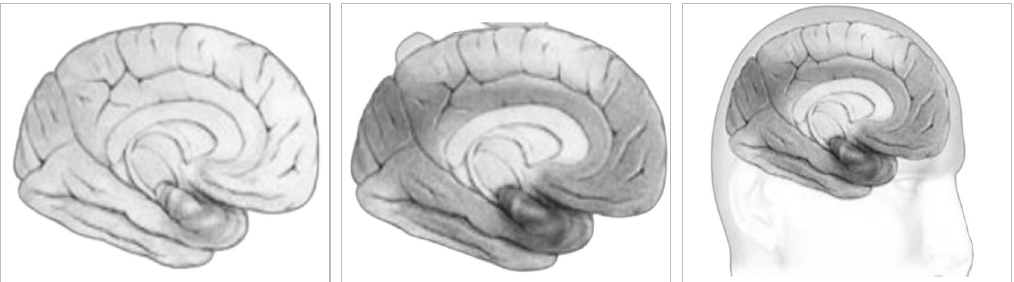
Figure 5: Senile plaques and neurofibrillary tangles in various stages of AD